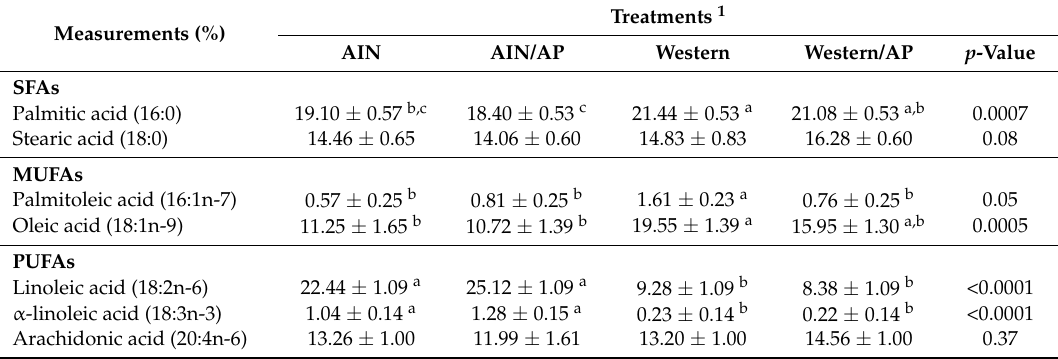
Table 5. Effect of consumption of different diets substituted with apple pomace (10% g/kg) by growing female rats on hepatic fatty acid composition following 8 weeks of feeding.